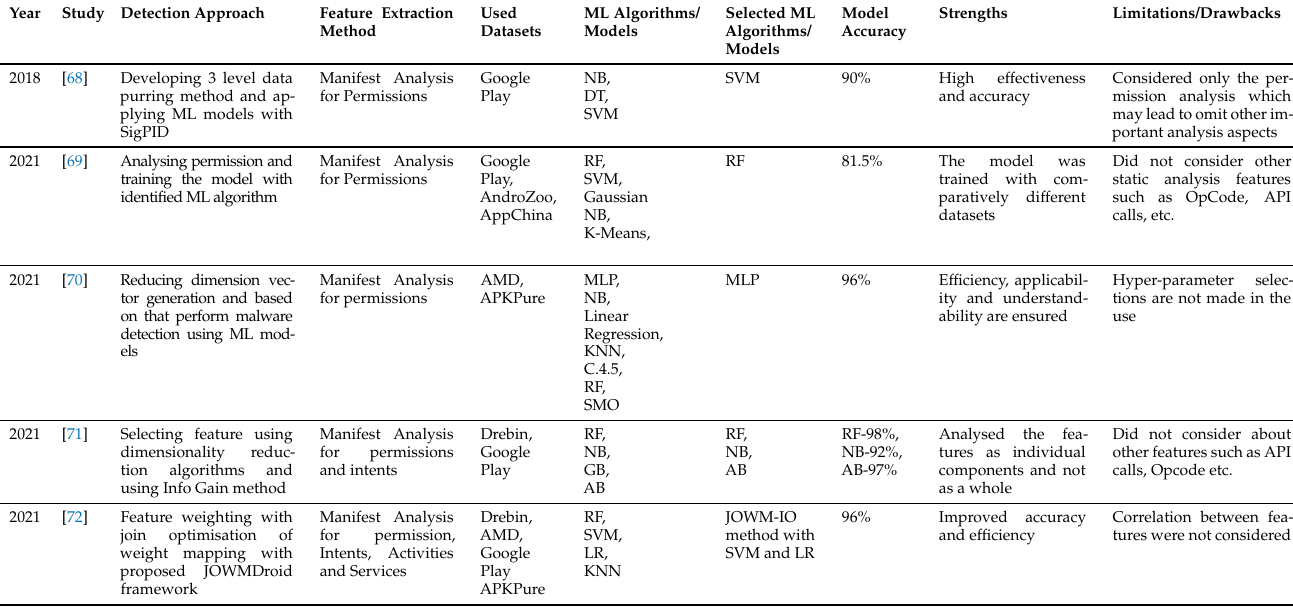
Table 1. Manifest based static Analysis with